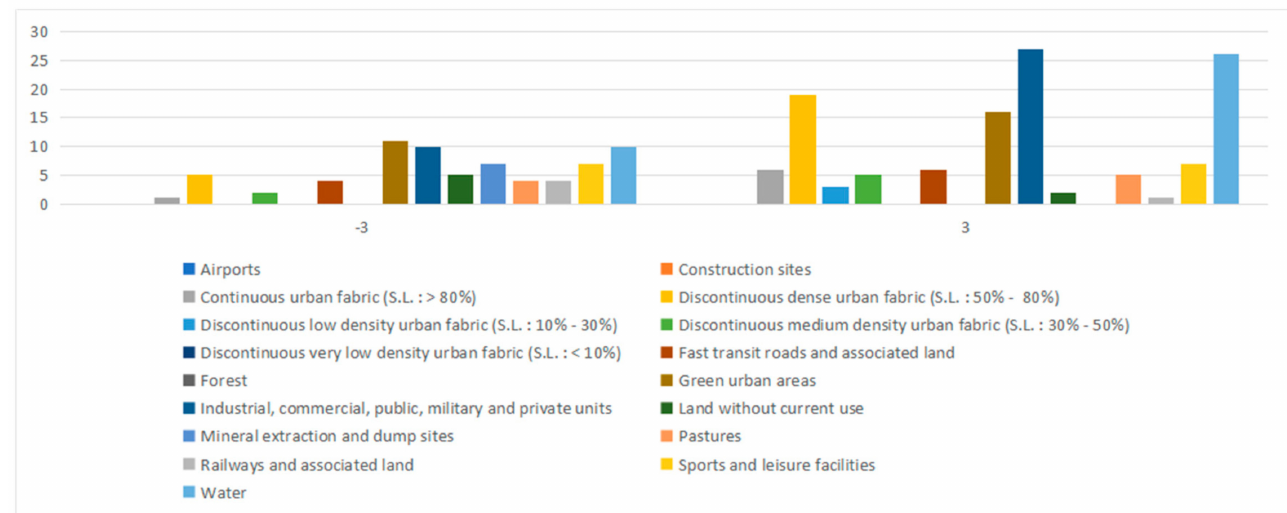
Figure 17. Quantity comparison of the land use dataset excluding arable land (annual crops) and other roads and associated land contained by the cold/hot spots with 99% confidence detected.